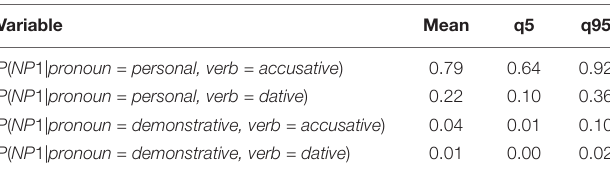
TABLE 6 | Value of P ( NP 1) across verb type and pronoun type for the Bayesian model, Experiment